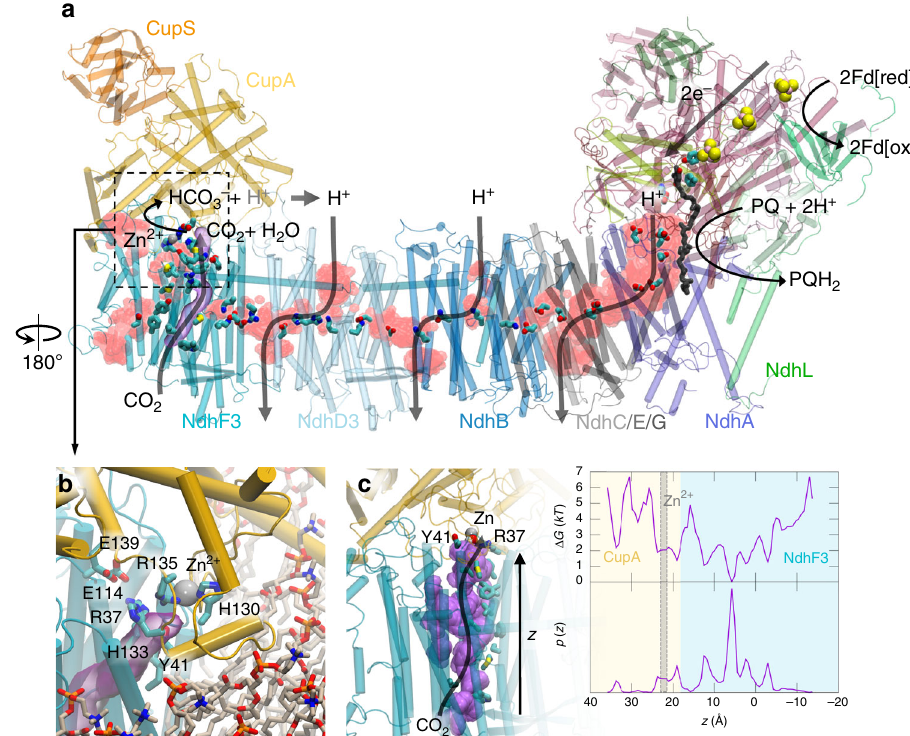
Fig. 3 Proton pathways and putative CO 2 channel in the photosynthetic complex I. a Location of proton pathways formed by water molecules (in red) during 250ns atomistic molecular dynamics simulations. The fi gure shows the overall water density during MD. b Closeup of the active site of CupA at the NdhF3 interface (in cyan) and the lipid membrane from MD simulations. The putative CO 2 channel (in purple), visualised based on CAVER analysis (see Methods), is surrounded by hydrophobic and bulky residues, and connects to the Zn 2 + -binding site by conserved Tyr41, Arg37, and Glu114 of the NdhF3 subunit (see Supplementary Fig. 6g for details). c Diffusion pathway of CO 2 molecules from the luminal side to CupA during MD simulations. Left: Dynamics of CO 2 in its putative gas channel in NdhF3. The average of the CO 2 position sampled during dynamics is represented as a purple surface. Right: Probability distribution and resulting potential of mean force (pmf in units of kT ), G ( z ) = − RT log( p ( z )), of CO 2 inside the channel along the membrane axis ( z -axis) obtained from 200 ns MD simulation. Owing to sampling gaps, the pmf is subjected to large